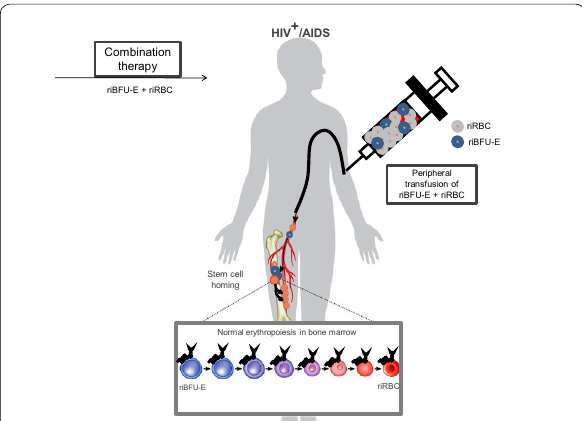
Fig. 3 Combination therapy to transfuse riBFU-E and riRBC into HIV- positive patient. riBFU-E and riRBCs will be transfused into peripheral blood of HIV patients as combination therapeutic strategy. Once inside patients’ body, riRBCs will be immediately functional to counter circulating HIV particles. On the other hand, riBFU-E from the periph- eral blood will find its way to the bone marrow by stem cell homing and will normally differentiate into riRBC that will further amplify the